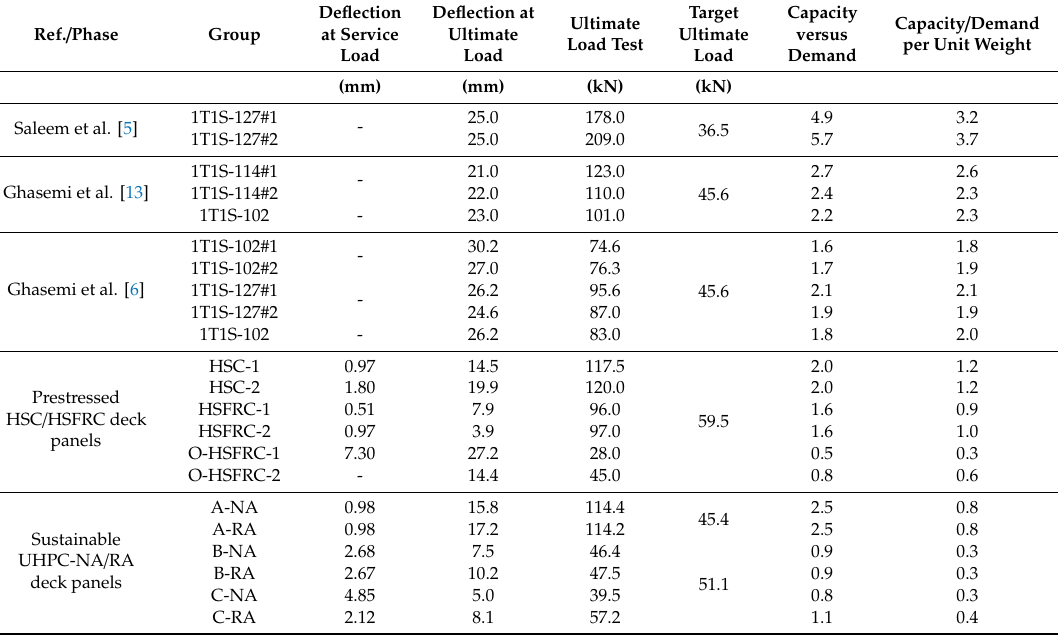
Table 5. Summary of testing